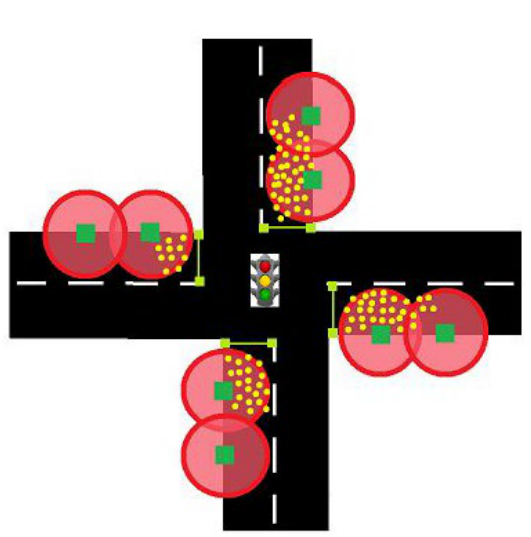
Figure 3. Iteration 1: Initial